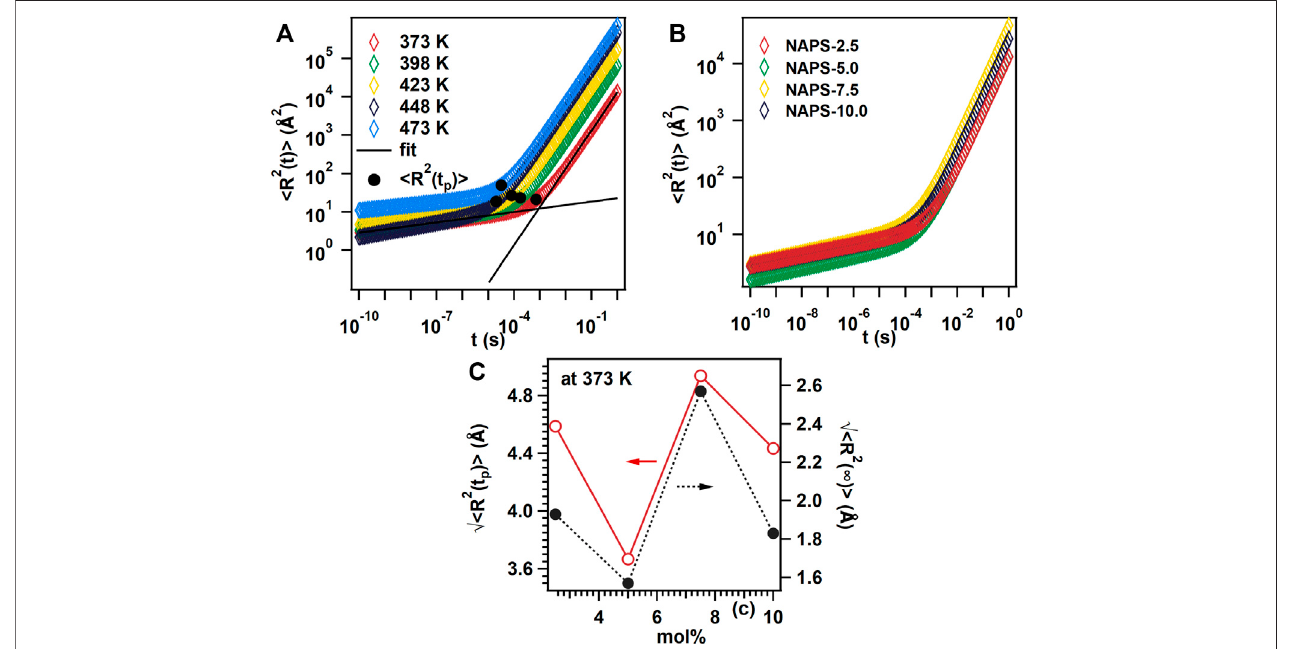
FIGURE 10 | (A) Mean square displacement with respect to time plot for NAPS-2.5 glass sample at different temperature. (B) Mean square displacement with respect to time plot for different glass sample at 373 K temperature. (C) Root mean square displacement with respect to time plot for different